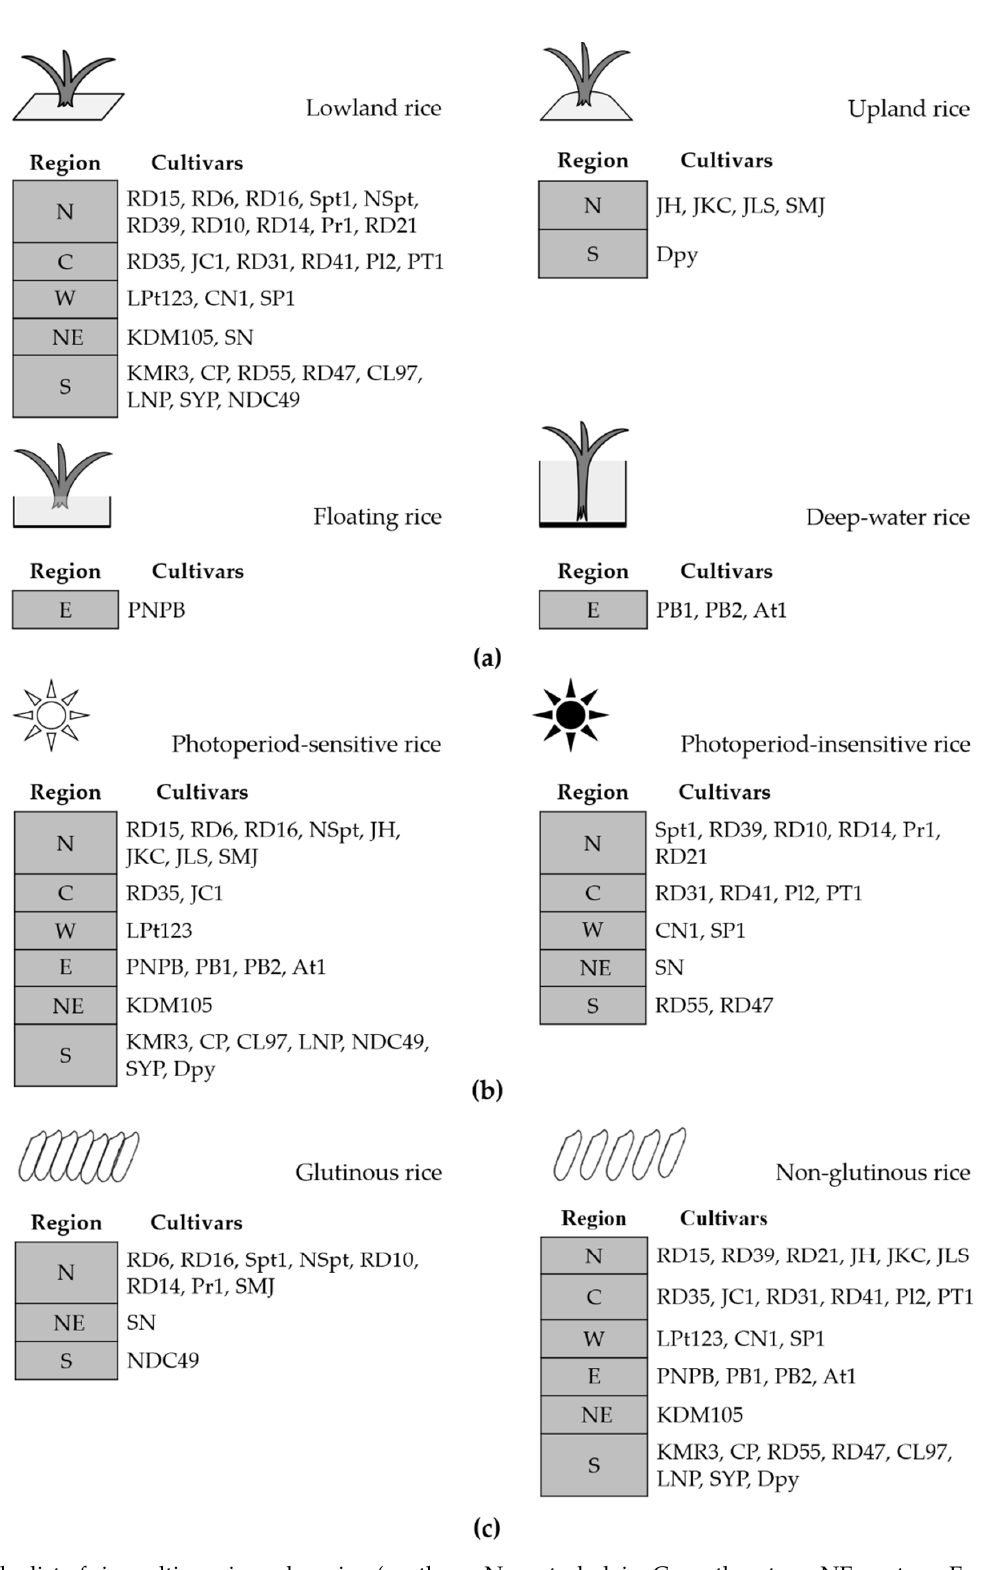
Figure 3. The list of rice cultivars in each region (northern, N; central plain, C; northeastern, NE; eastern, E; western, W; southern, S) categorized according to three factors ( a ) riceland ecosystem; ( b ) photoperiod sensitivity; and ( c ) texture of cooked rice. Abbreviations for the rice cultivars are in Table 1 .